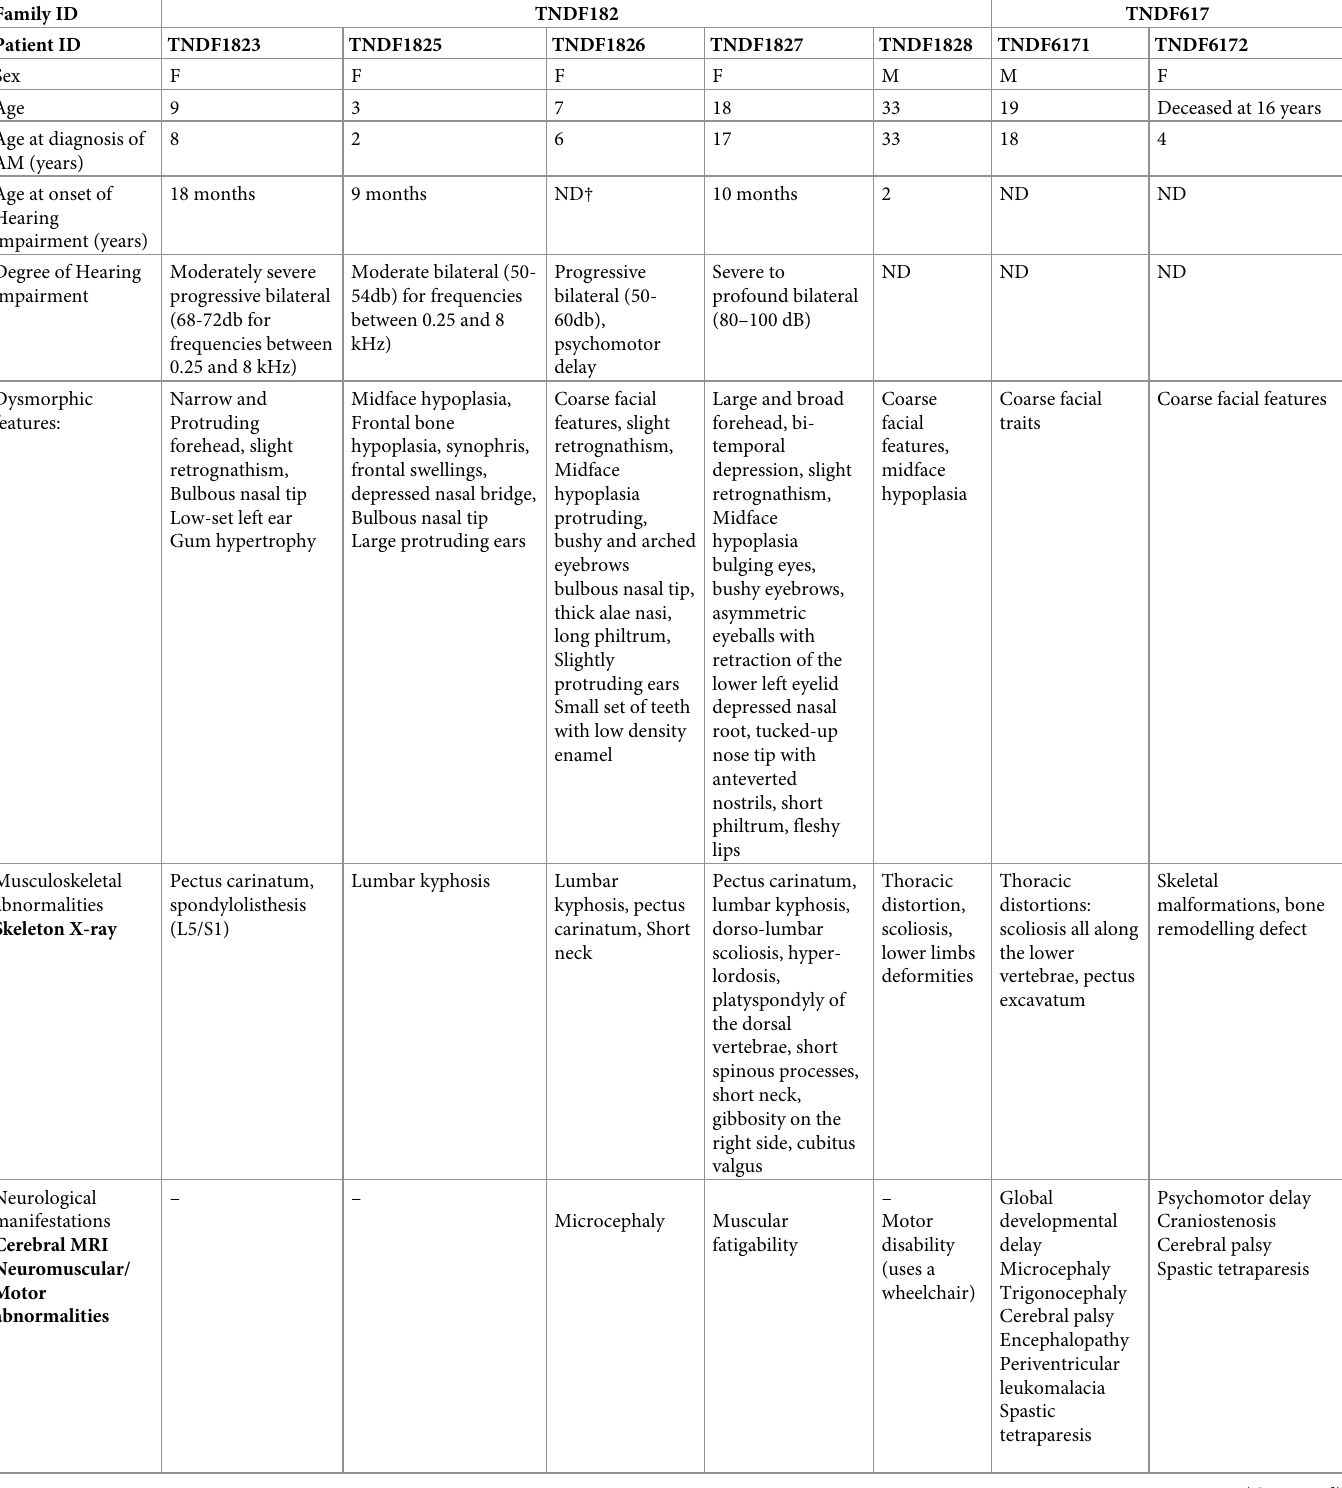
Table 1. Clinical features of all investigated